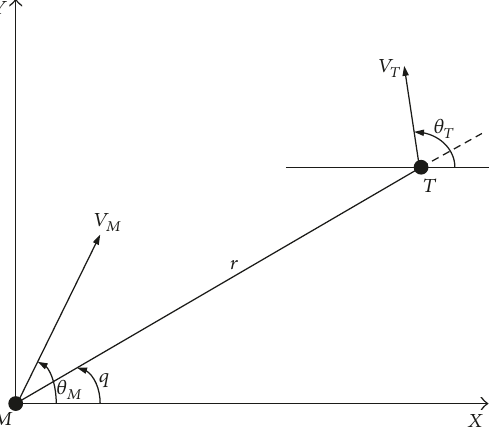
Figure 1: Relative motion relationship of UAV and